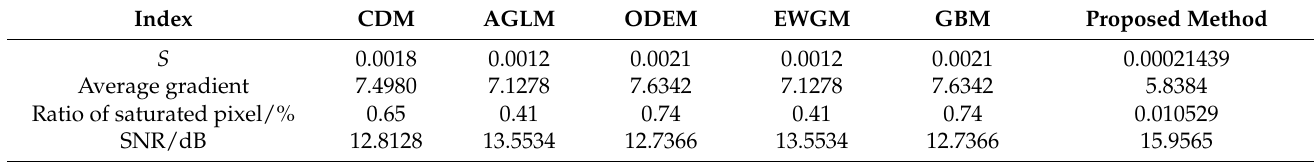
Table 2. Comparison of quantitative indices of the optimal exposure image of each method under bright conditions.